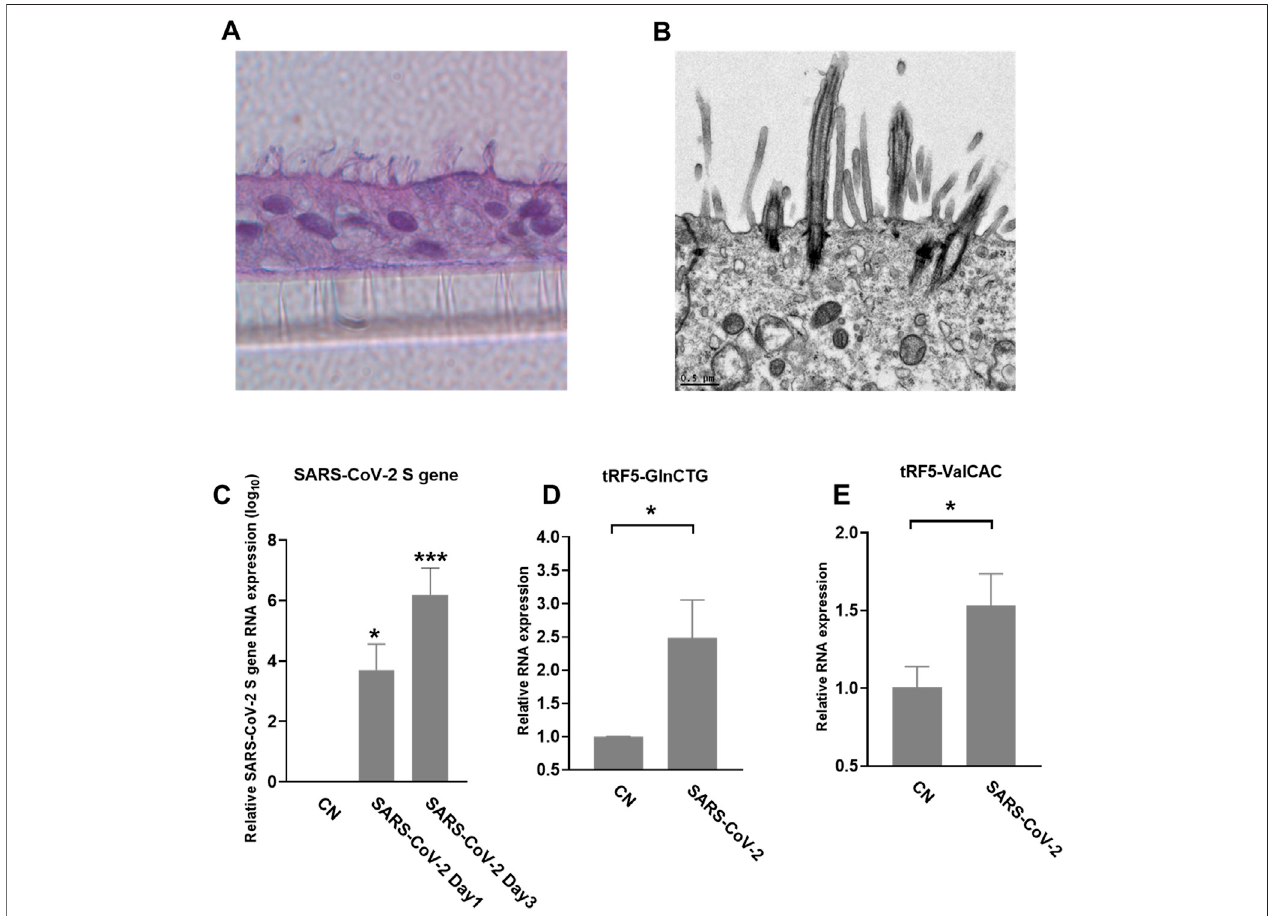
FIGURE5| SARS-CoV-2-affectedtRF5sinALI-culturedSAECs. (A) HistologicalexaminationSAECsinALIculture.AfterSAECswereinALIculturefor21days,the insert was fi xed with 4% polyoxymethylene, followed by tissue processing, sectioning, and H&E staining. (B) Transmission electron microscopy (TEM) of SAECs in ALI culture. (C) ALI-cultured SEACs were apically infected with SARS-CoV-2 at an MOI of 0.1 for 1 or 3 days, qRT-PCR was performed to detect SARS-CoV-2 S gene expression.GAPDHwasusedasaninternalcontrol. (D,E) Onday3postinfection,tRF5-GlnCTG (D) andtRF5-ValCAC (E) expressionsweremeasuredusingqRT- PCR.Mock-infectedcellswereusedascontrol(CN).Unpairedtwo-tailedt-testswereperformedforstatisticalcomparisons.Singleasterisksrepresent p valuesof < 0.05. Data are shown as means ± SE and are representative of three independent experiments.